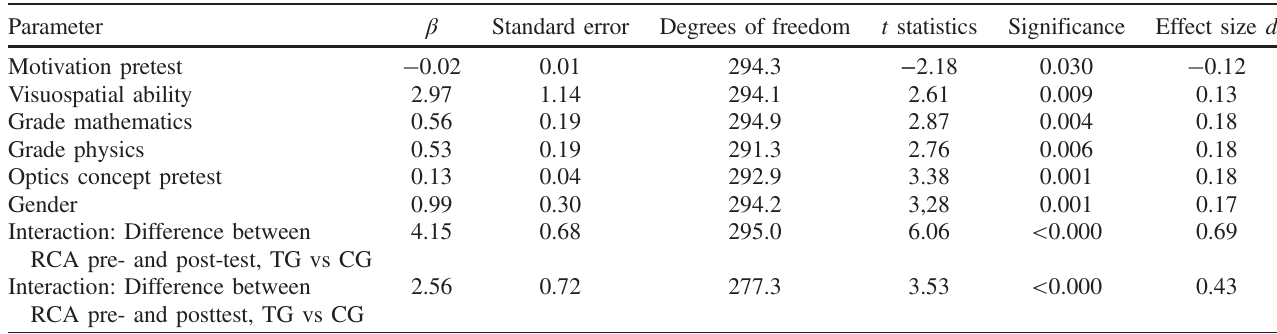
VI. Results of the multilevel analysis for the S- and DU-assessment items together: influence of variables on students ’ RCA (not shown: nonsignificant variables, viz. verbal and numeric intelligence, and German language grade). The full table of all items and separated tables for S and DU assessment items are shown in Appendix